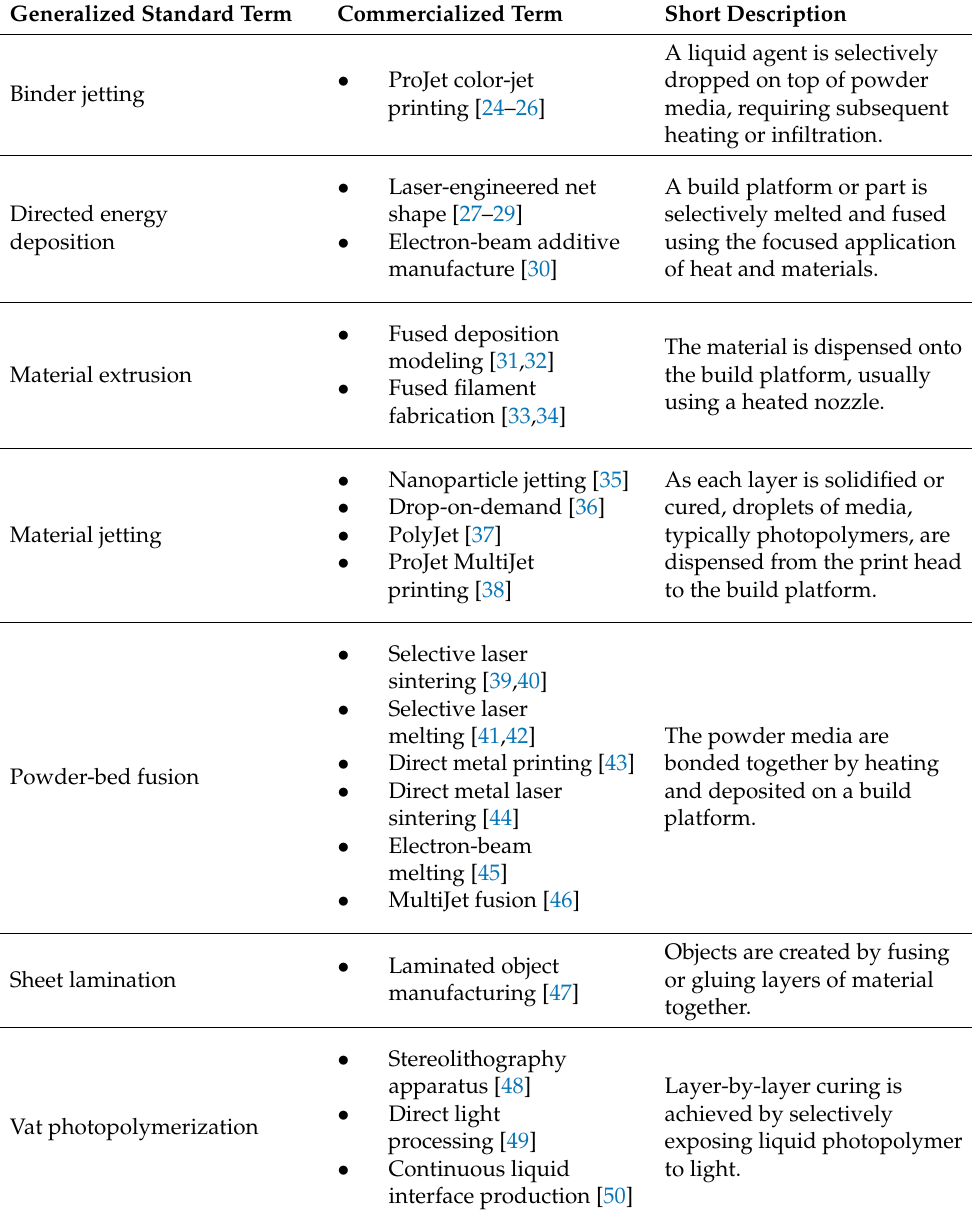
Table 1. Generalized standard and commercialized terms, corresponding descriptions, and references for AM